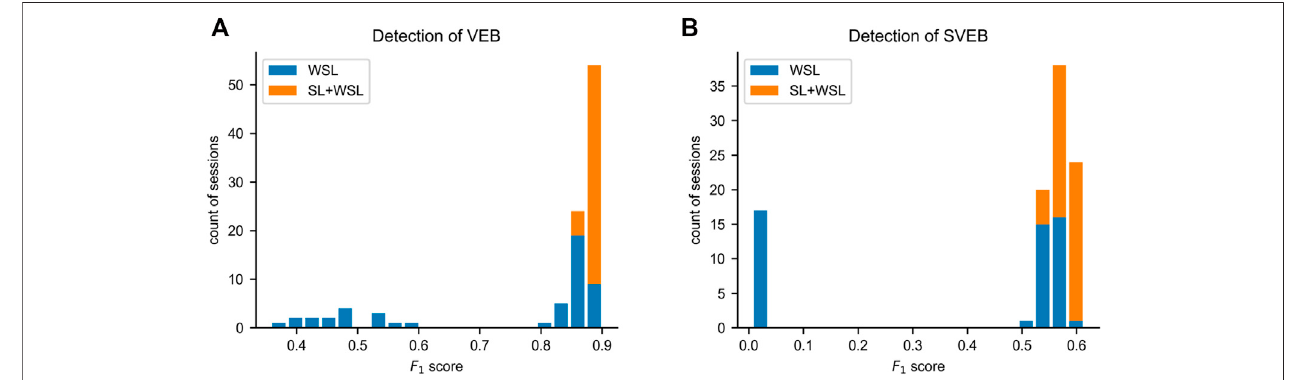
FIGURE6| Distributionsofthe F 1 scoresonthetotaltestdatainmultipleindependenttrainingsessions. (A) Thehistogramoftheresultsforventricularectopicbeat (VEB) detection. (B) The histogram of the results for supraventricular ectopic beat (SVEB) detection. SL = supervised learning. WSL = weakly supervised learning.